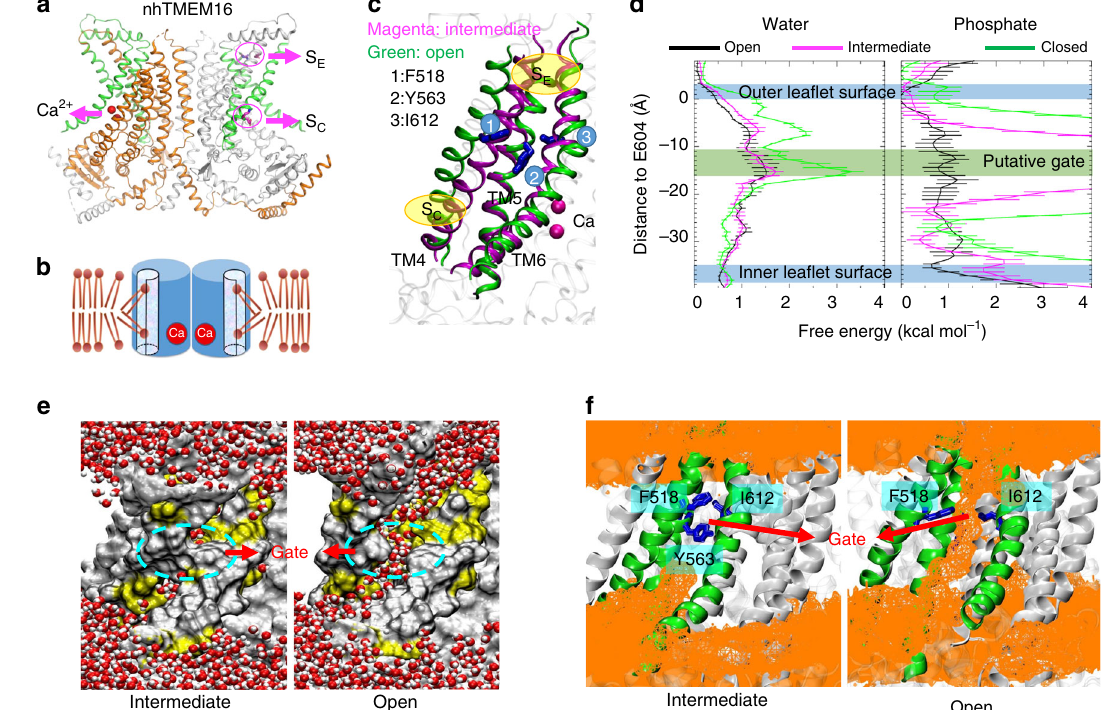
Fig. 1 F518, Y563, and I612 form a putative inner activation gate for TMEM16F-CaPLSase. a X-ray structure of nhTMEM16 (PDB: 4WIS). The two monomers are colored in grey and brown, respectively. The transmembrane (TM) helices 4 – 6 lining the interior of the hydrophilic groove are highlighted in green. The bound Ca 2 + ions are represented as red spheres. Previously proposed S E and S C sites are marked with magenta circles. b A schematic representation of the credit-card reader model for phospholipid permeation through CaPLSases. c Superposition of TMs 4 – 6 in the predicted intermediate and open state models of TMEM16F. The intermediate was derived from the Ca 2 + -bound TMEM16A structure (PDB: 5OYB), and the open con fi guration was derived from the hybridization of the Ca 2 + -bound TMEM16A structure (PDB: 5OYB) and the Ca 2 + -bound nhTMEM16 structure (PDB: 4WIS) (see Methods for details). Side chains of the putative inner activation gate residues are shown in blue sticks and numbered as 1, 2, and 3, respectively. d Effective free energy pro fi les of water (left) and phosphates (right) along the hydrophilic groove derived from the average densities from the last 100 ns of the 400 ns atomistic simulations of TMEM16F in open (black), intermediate (magenta), and closed (green) states. The y -axis is the relative distance from E604, a residue at the outer lea fl et surface. The standard errors were estimated from the calculated averages over three independent simulations. e Snapshots from the atomistic simulations of the open or intermediate TMEM16F homology models. The protein is represented as silver surfaces and all polar residues in TMs 4 – 6 are colored in yellow. Waters within 15 Å of the protein are represented as stick-and-balls. f Phosphate densities near TMs 4 – 6 (green cartoons) derived from atomistic simulations. The phosphate accessible region (probability > 0.005) is represented as orange grid. Three putative gate residues (F518, Y563, I612) are represented as blue